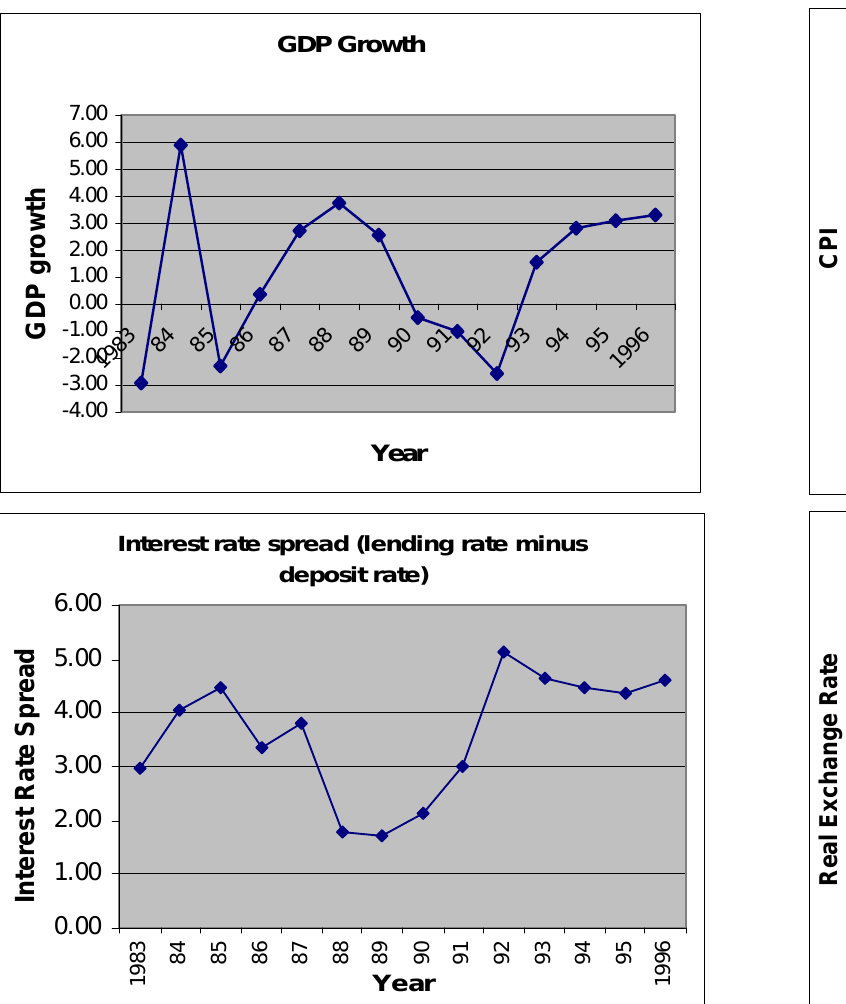
Figure 3 Macroeconomic performance